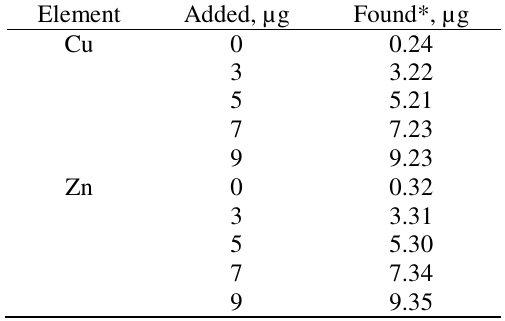
Table 2. Recovery of Cu and Zn in drinking water sample (N=5 , volume: 500 mL) Element Added, µg Found*, µg Cu